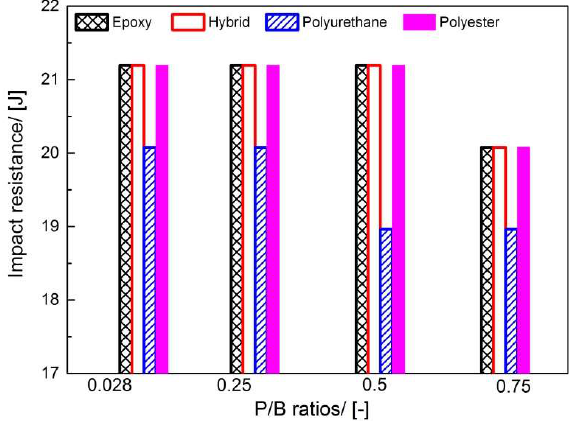
Figure 4. Impact resistance of formulations with different resins and P/Bs.